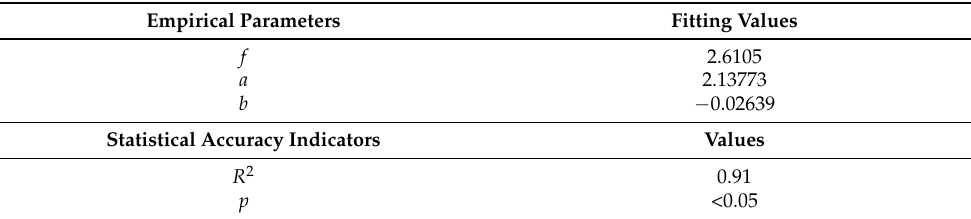
Table 7. Parametric values to predict Nu from Equation (40).